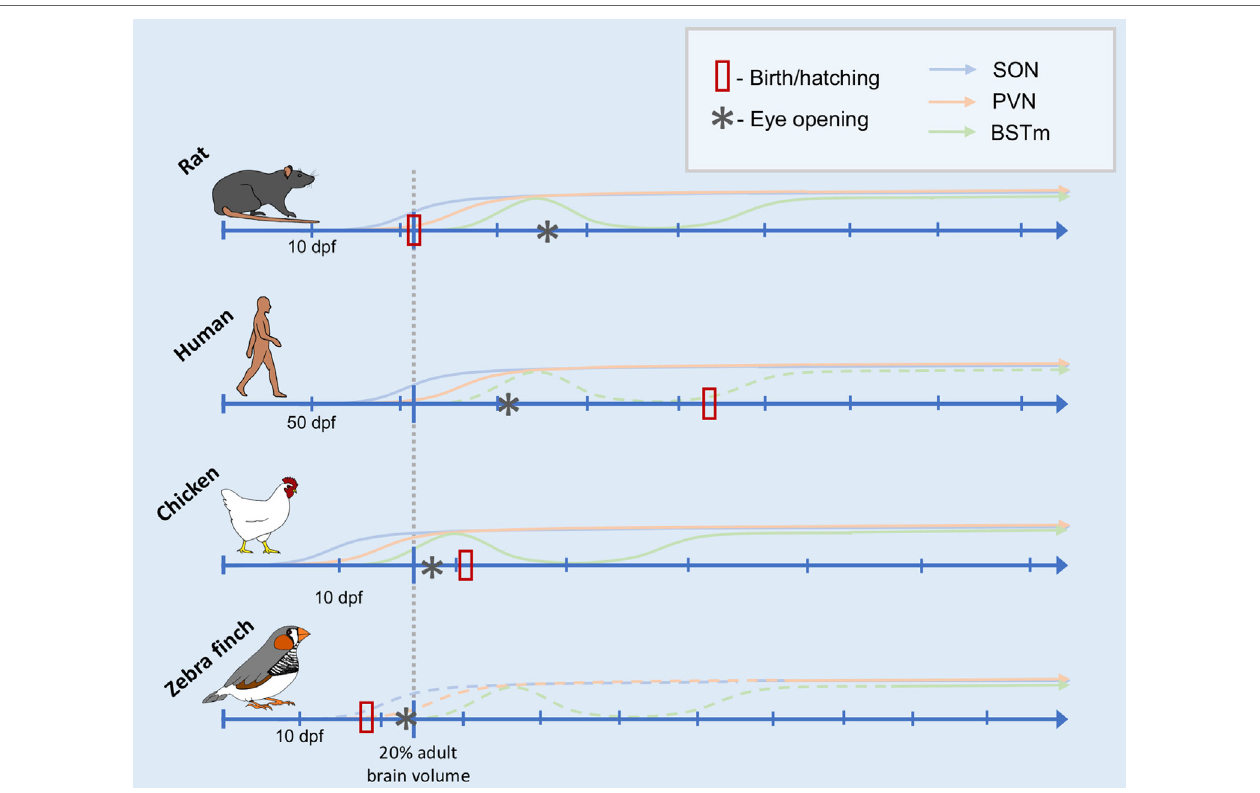
FiGURe 1 | Comparative timeline of arginine vasotocin (AVT)/arginine vasopressin (AVP) cell group development. Conceptual timeline illustrating the production of AVT/AVP across early development in rats, humans, chickens, and zebra finches in three main AVT/AVP cell groups: the supraoptic nucleus (SON, blue), paraventricular nucleus (PVN) of the hypothalamus (PVN, orange), and the medial bed nucleus of the stria terminalis (BSTm, green). The x -axis of the timeline is scaled to the neurodevelopmental time point of when the organism is estimated to reach 20% total adult brain volume (indicated by the gray dotted line intersecting each timeline). Days postfertilization (dpf) are indicated by hatchmarks along each timeline. Solid lines indicate solid data (see text for references), whereas dotted lines are predicted results. The data from which this illustration is created include counts of AVT/AVP immunoreactive cells, mRNA expression, and peptide concentrations (see Table 1 ). Thus, the y -axis does not have a scale, as it is not clear how these different data types are comparable across species, cell group, study, etc. The date of hatching or birth for each species is indicated by a red rectangle. Date of eye opening is indicated by an